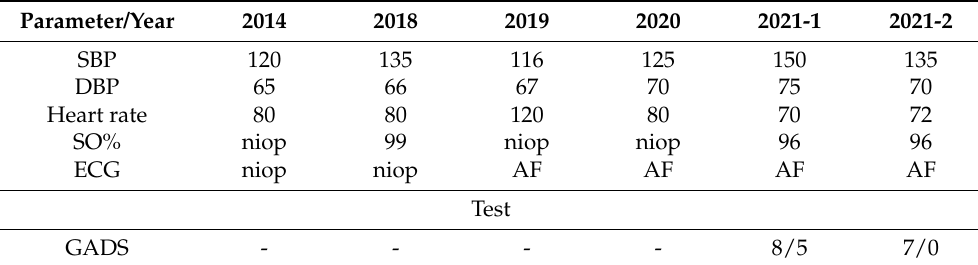
Table 3. Control cardiac and psychological